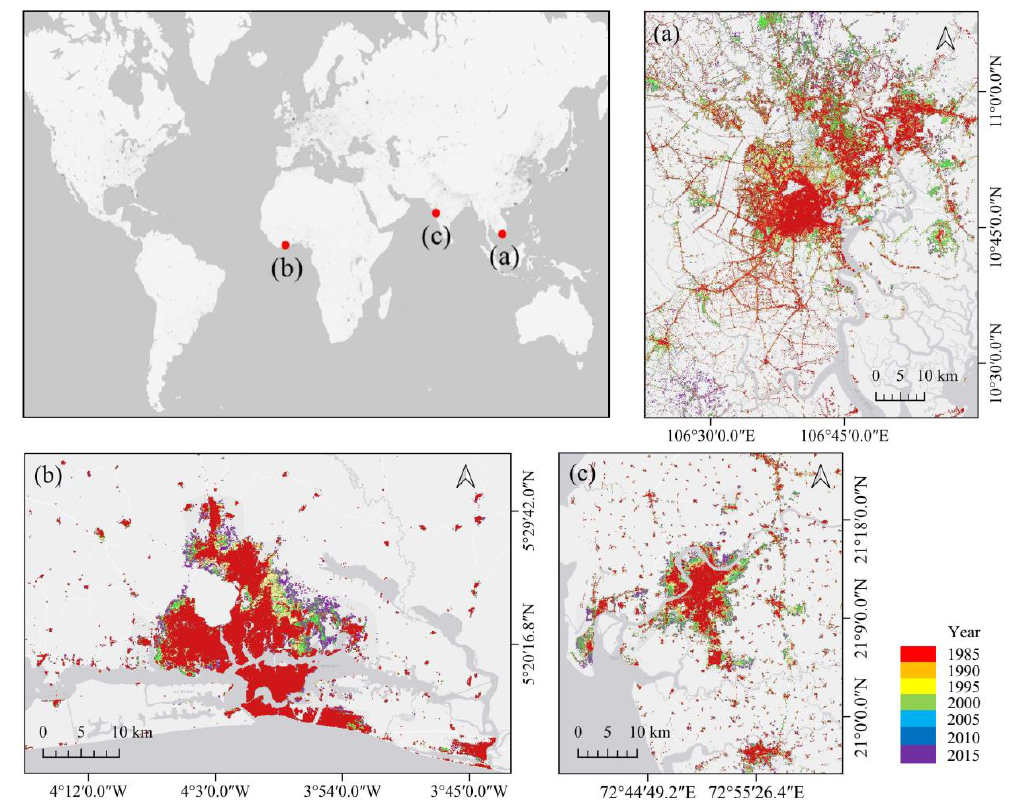
Figure 2. WSF-evolution: overview maps; ( a ) HCMC in Vietnam; ( b ) Abidjan in the Ivory Coast; and ( c ) Surat in India.